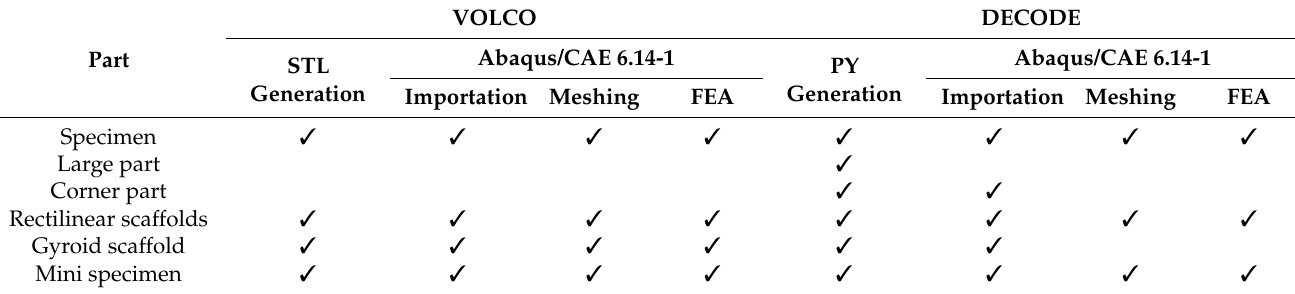
Table 8. Part Simulation Feasibility.